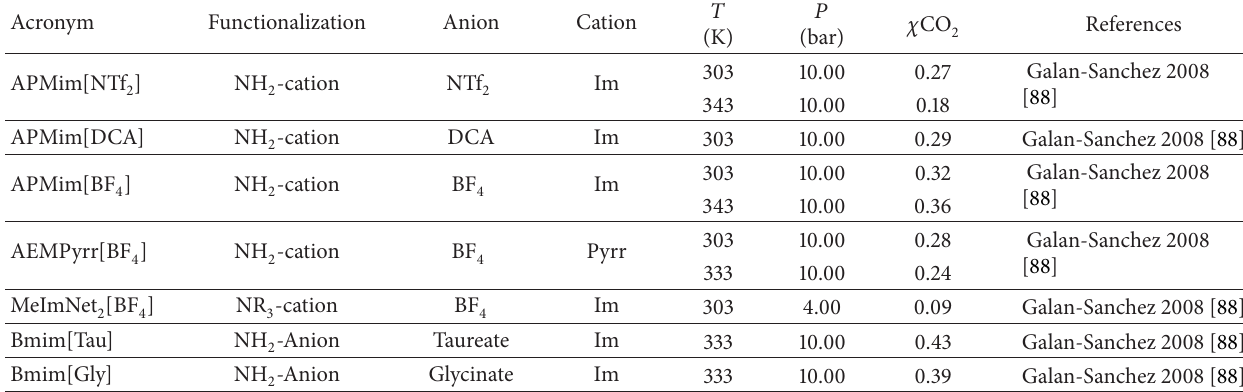
Table 7: CO Solubility data for functionalized ionic liquids 2